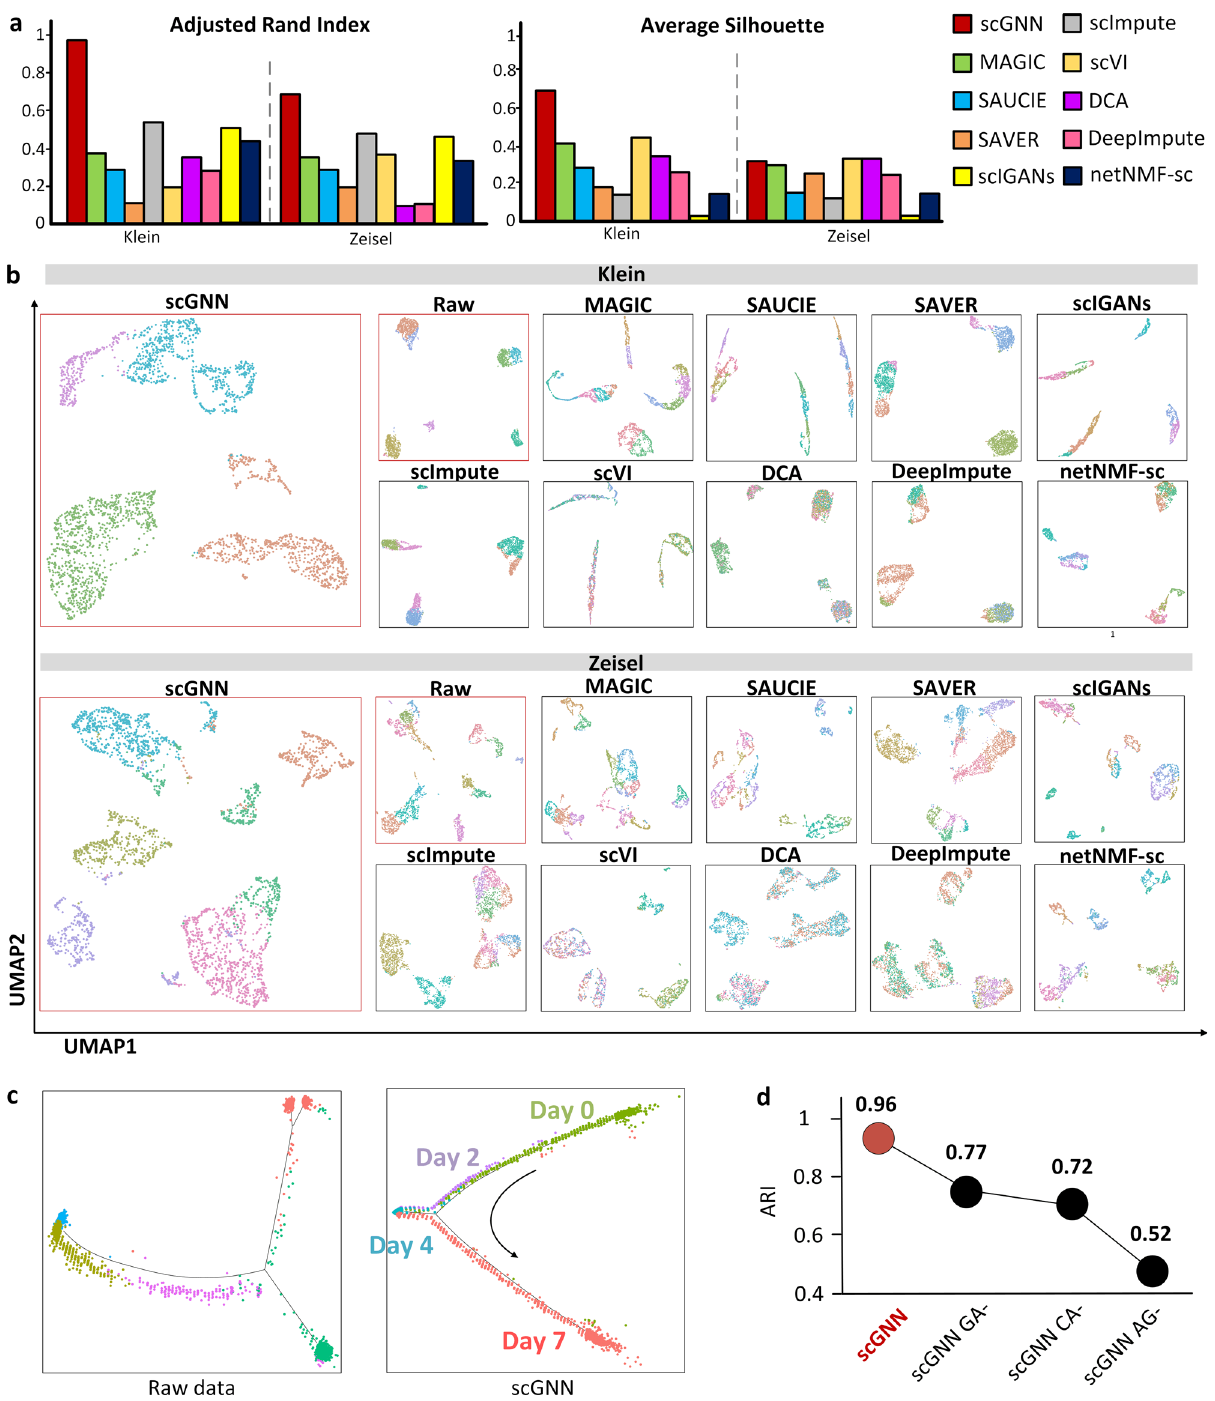
Fig. 4 Cell clustering and trajectory evaluations. a Comparison of ARI and Silhouette scores among scGNN and nine tools using Klein and Zeisel data sets. b Comparison of UMAP visualizations on the same two data sets, indicating that when scGNN embeddings are utilized, cells are more closely grouped within the same cluster but when other tools are used, cells are more separated between clusters. Cells were clustered via the Louvain method and visualized using UMAP. c Pseudotime analysis using the raw expression matrix and scGNN imputed matrix of the Klein data set via Monocle. d Justi fi cation of using the graph autoencoder, the cluster autoencoder, and the top 2000 variable genes on the Klein data set in the scGNN framework, in terms of ARI. scGNN CA- shows the results of the graph autoencoder ’ s ablation, CA- shows the results of the cluster autoencoder ’ s ablation, and AG shows the results after using all genes in the